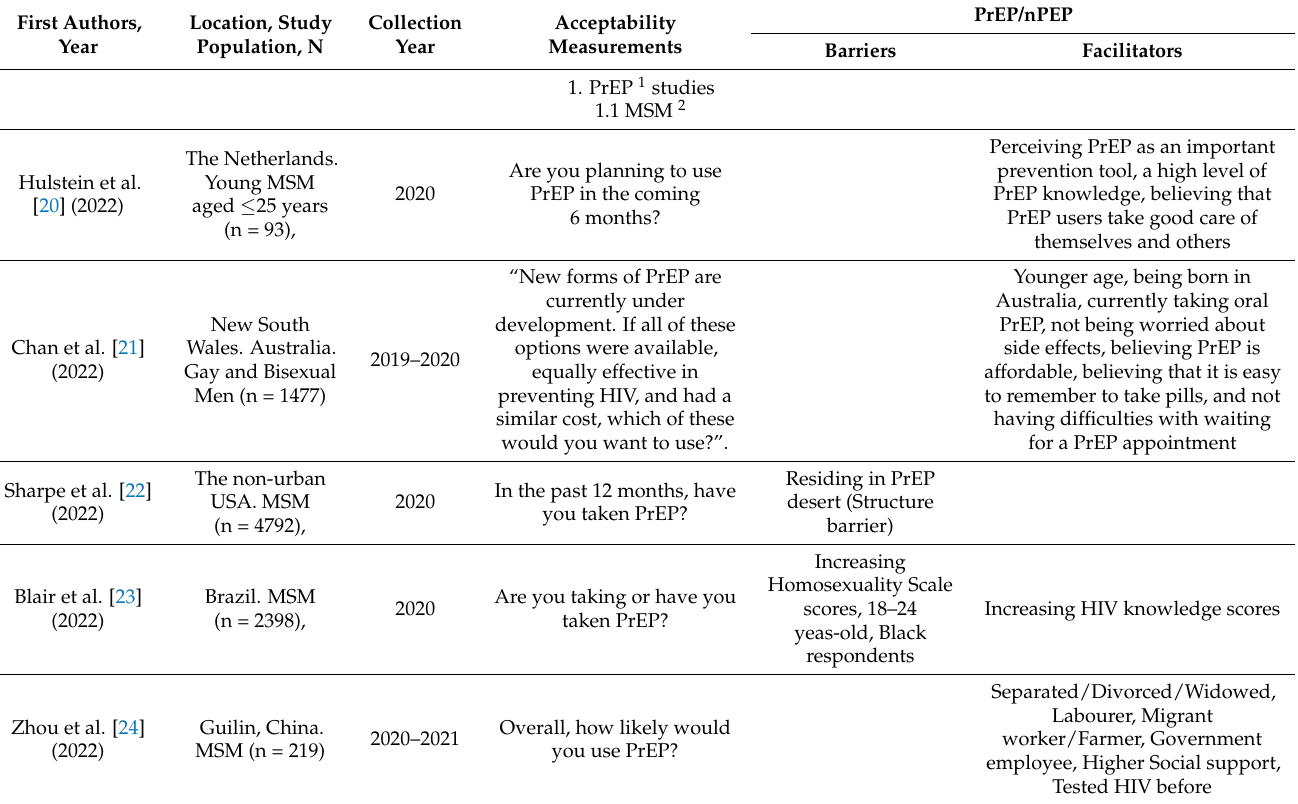
Table 1. Characteristics of included studies (ordered by